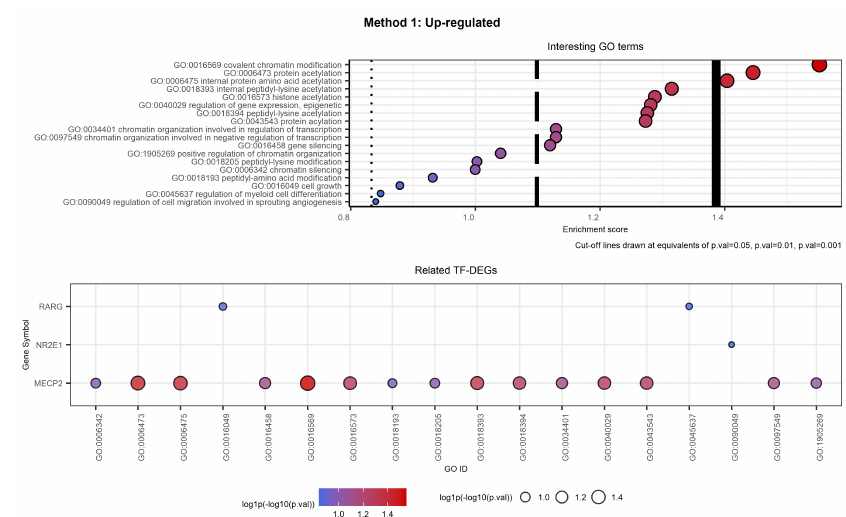
Figure 12. Interesting GO terms and related TF-DEGs. The first plot shows selected GO terms on the y -axis and the respective log1p( − log10( p -value)) as the Enrichment score on the x -axis. The second plot shows on the y -axis the TF-DEGs and the related GO terms on the x -axis. In both plots, colour and size of the bubbles depend on the Enrichment score. We note that gene MECP2 is involved in almost all the selected GO labels, while genes RARG and NR2E1 result in being specific.